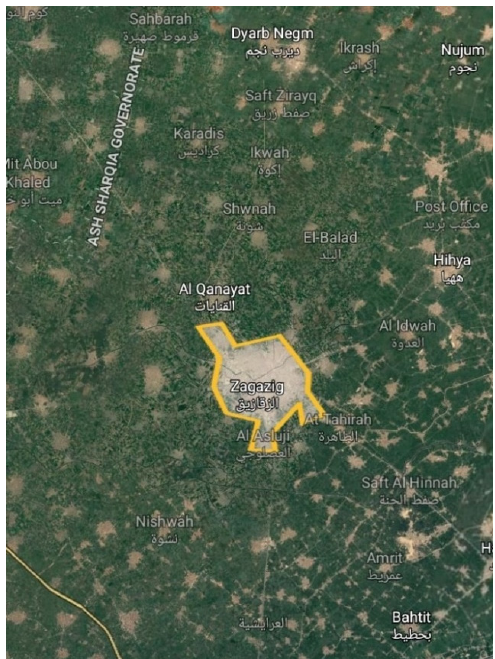
Figure 12. Urbanised area of Zagazig.